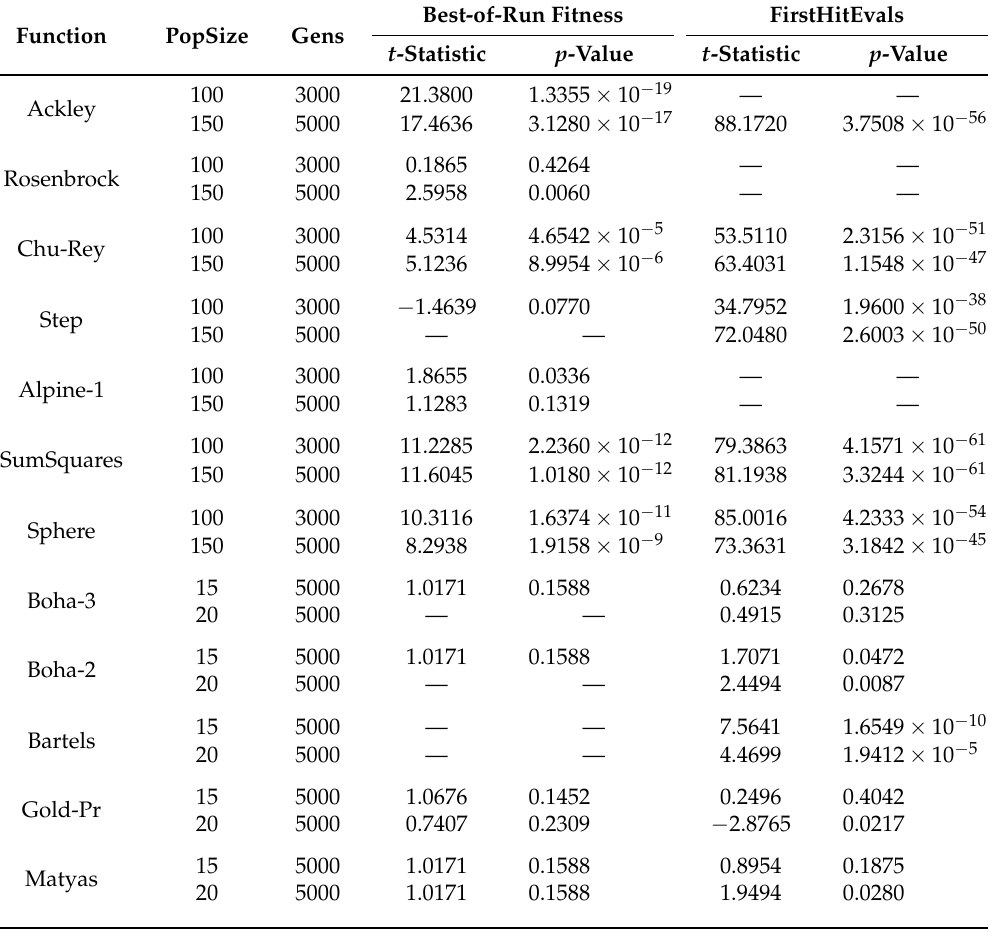
Table 4. Smith–Satterthwaite tests: Jaya vs. SJaya on the benchmark